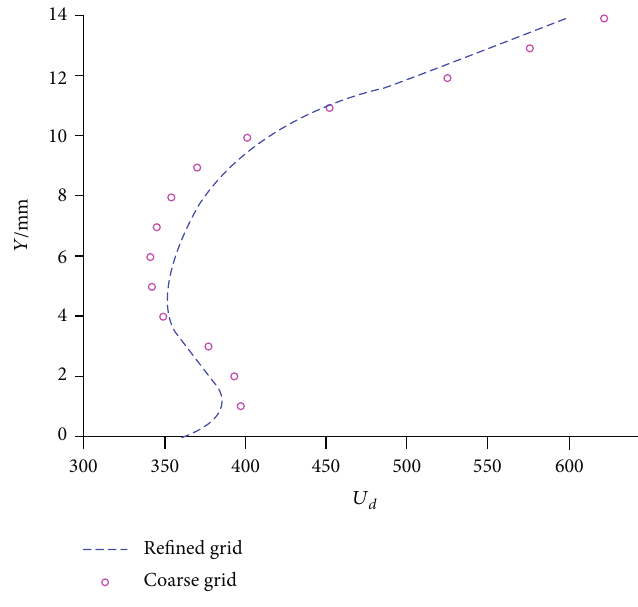
Figure 21: Velocity of droplet comparison at x = 50mm between two sets of grids. Table 6: Operational conditions with di ff erent nozzle diameters and air fl ow Ma.